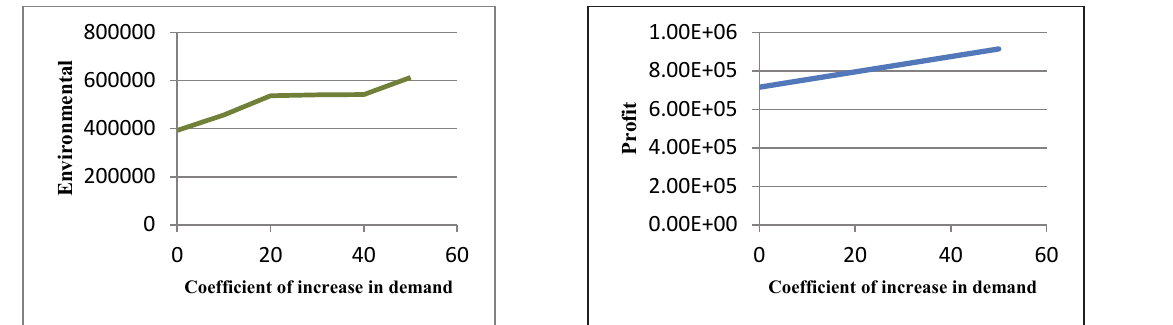
Fig. 2. The analysis of increasing the demand of retailers on profit